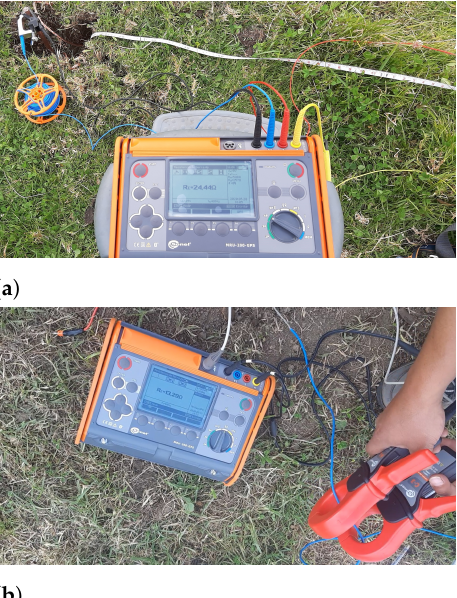
Figure 7. Grounding resistance (GR) measurements. ( a ) FOP method; ( b ) Clamp-on method.